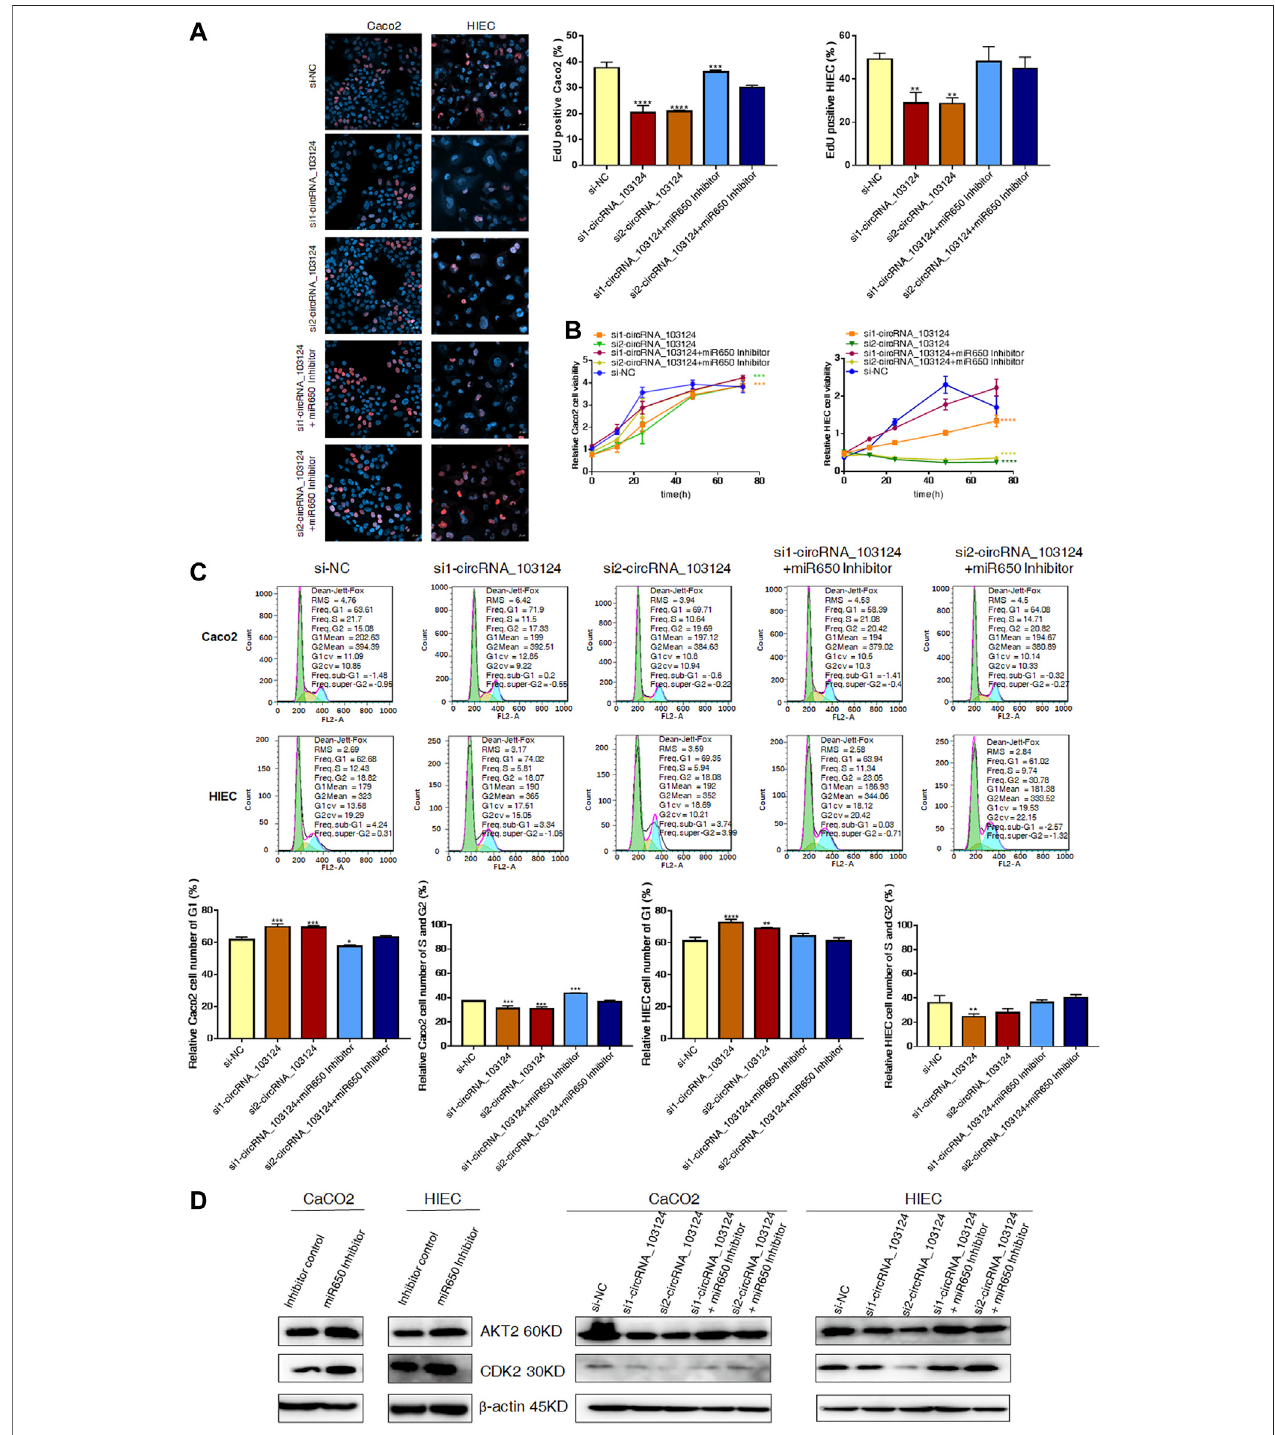
FIGURE4| Thehsa-miR-650 inhibitor rescuedtheinhibitionofcellproliferationinducedbythehsa_circRNA_103124siRNA. (A,B) Cellproliferationwasassessed using 5-ethynyl-2 ′ -deoxyuridine stainingand theCCK-8assay. (C) The cellcycledistribution wasdetected using fl ow cytometry followingpropidiumiodidestaining. (D) Relative expression of AKT2 and CDK2 was detected using western-blotting, and normalized to β -actin. si-NC, cells transfected with negative control of hsa_circRNA_103124 siRNA. si1-circRNA_103124, si2-circRNA_103124, cells transfected with the hsa_circRNA_103124 siRNA; Inhibitor control, cells transfectedwiththenegativecontrolofthehsa-miR-650inhibitor.si1-circRNA_103124+miR650Inhibitor,si2-circRNA_103124+miR650Inhibitor,cellscotransfected withhsa_circRNA_103124siRNAandhsa-miR-650inhibitor.Inhibitorcontrol,cellstransfectedwiththenegativecontrolofhsa-miR-650inhibitor.miR650Inhibitor,cells transfected with hsa-miR-650 inhibitor.